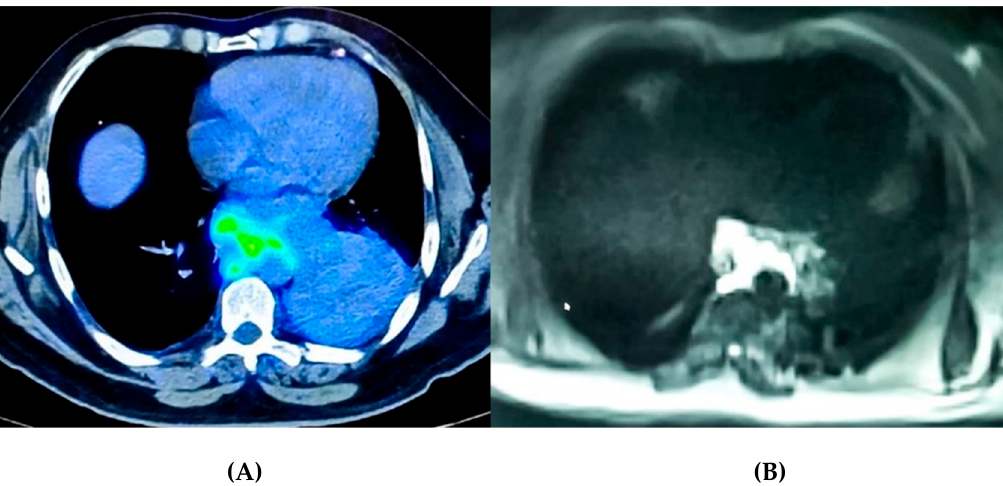
Figure 2. Matching functional and morphological imaging data. ( A ) CT/PET image showing a marked uptake of the tracer by a lymph node mass (with poor tissue uptake in the costo-vertebral shower). ( B ) IVIM sequence performed on the same patient. Comparing the two images, it can be observed that even if the CT/PET scan allows a greater morphological detail, the IVIM sequence has an equal capacity to highlight, with hyper ‐ intensity of the signal, the same functional aspects.